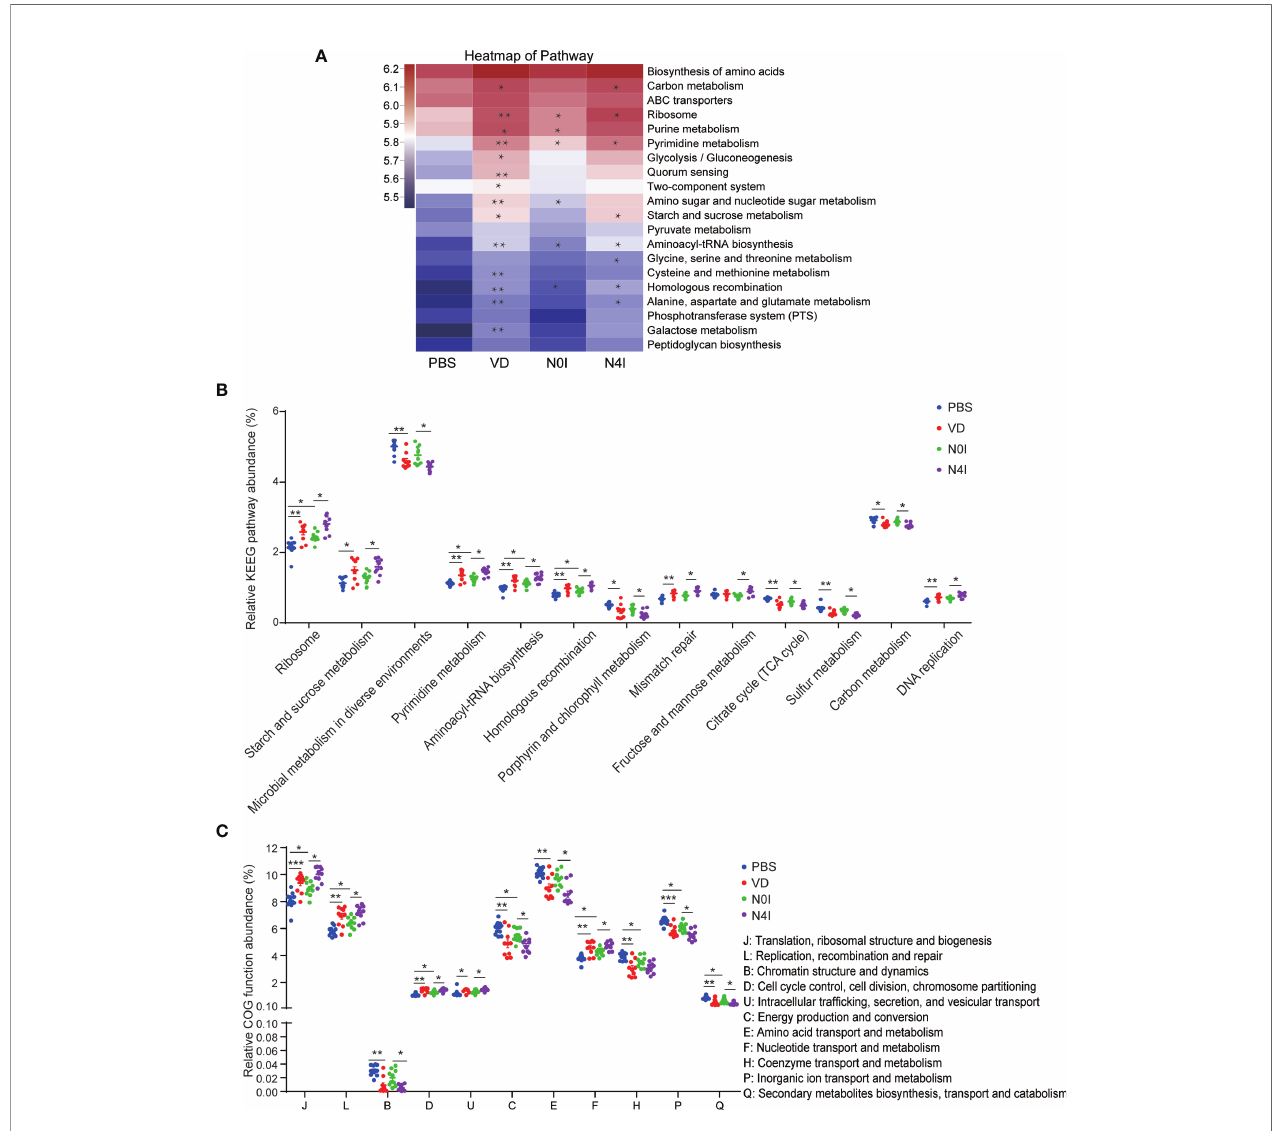
FIGURE 6 | Differentially enriched functions of gut microbiota among control, VD, and mCRAMP-treated mice by PICRUSt analysis. The functions were predicated by KEGG (A, B) and COG (C) database in control, VD, and mCRAMP-treated mice. (A) Heatmap showing the top 20 pathways of the abundance, which was colored by logarithmic value, and the signi fi cant difference between the groups (VD vs PBS, N0I vs PBS, N4I vs N0I) were marked. (B) Pathways with over 0.1% changes compared to control group were shown. (C) The signi fi cantly different COG functions. * p < 0.05; ** p < 0.01. *** p < 0.001 indicates statistical signi fi cance using Welch ’ s t-test and adjusted false discovery rate. The heatmap was analyzed using PICRUSt package by R software, and (B, C) were generated by Graphpad Prism 7 (GraphPad Software Inc, LaJolla, CA,